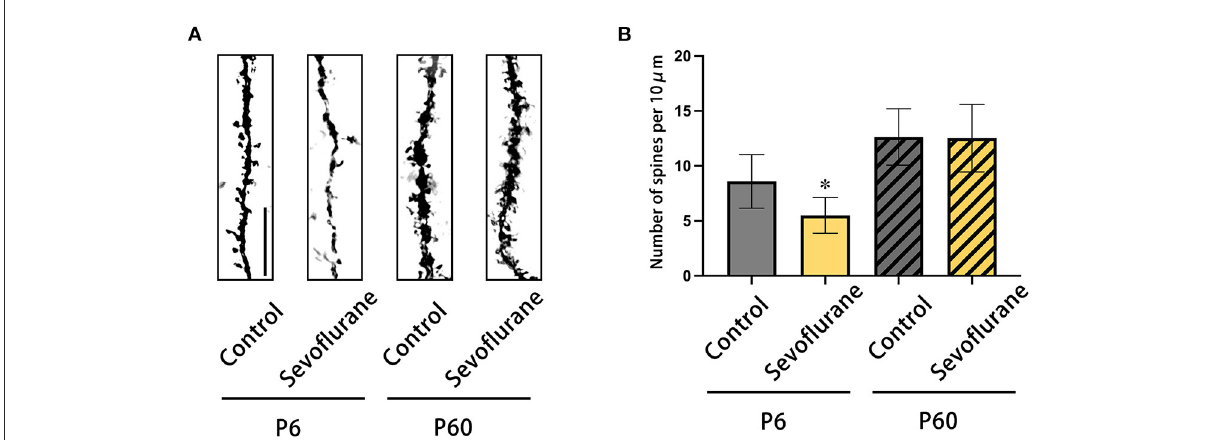
FIGURE3 The results of Golgi-Cox staining on the dendrites of pyramidal neurons of cerebral cortex in layers 4/5. (A) Representative photomicrographs of Golgi-Cox-stained dendrites (scale bar, 1 µ m). (B) The dendritic spine density (numbers of dendritic spine/10 µ m). n = 20 dendrites/mice. * P < 0.05 vs. P6 + Control. P6, postnatal day